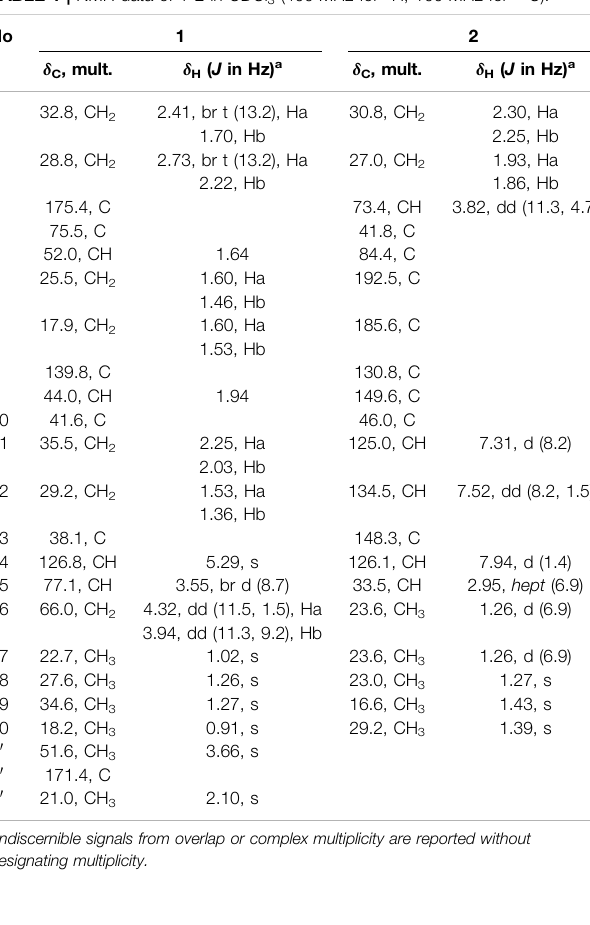
TABLE 1 | NMR data of 1-2 in CDCl 3 (400 MHz for 1 H; 100 MHz for 13